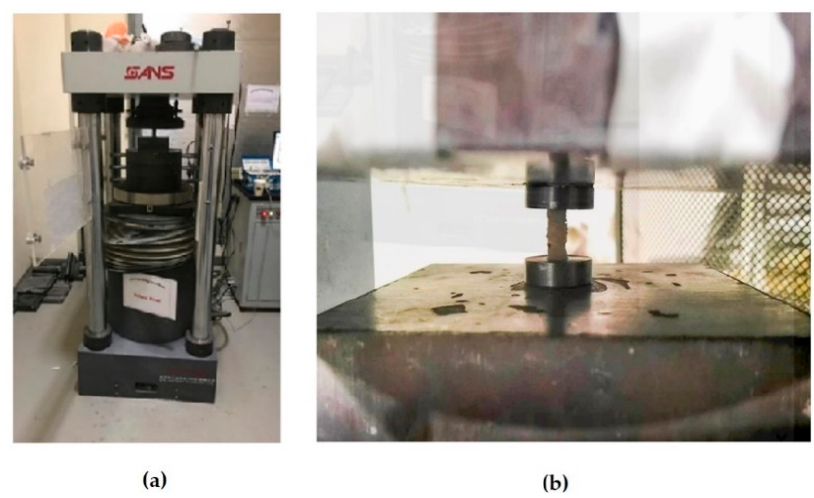
Figure 3. ( a ) Compression testing machine; ( b ) sample of the tested specimen.